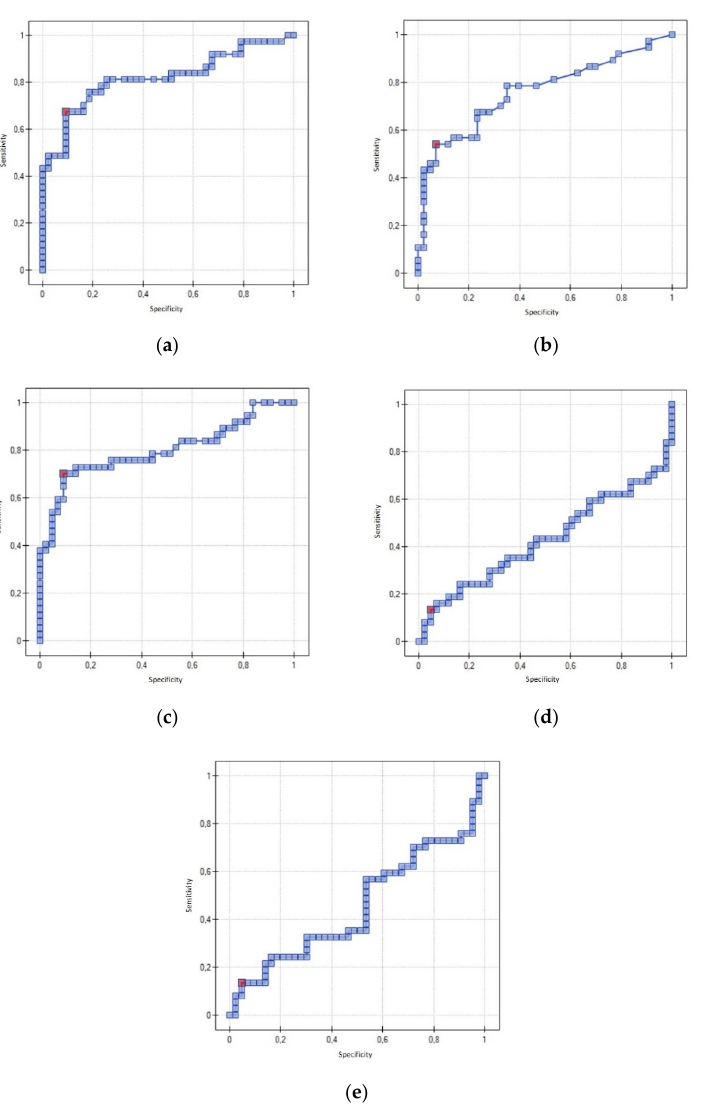
Figure 1. Receiver operating characteristic curve for using ( a ) PD-1, ( b ) PD-L1, ( c ) CTLA-4, ( d ) CTLA-4/PD-L1, and ( e ) PD-1/PD-L1 to distinguish between ovarian cancer and benign ovarian cystic lesions.